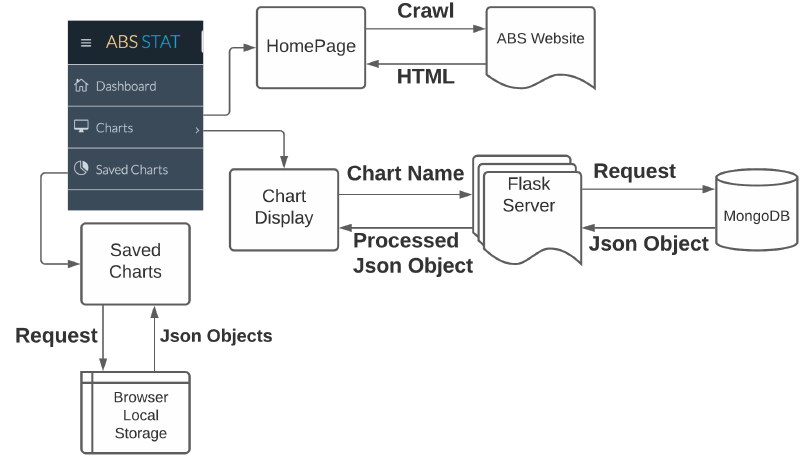
Figure 1. Framework of the Web